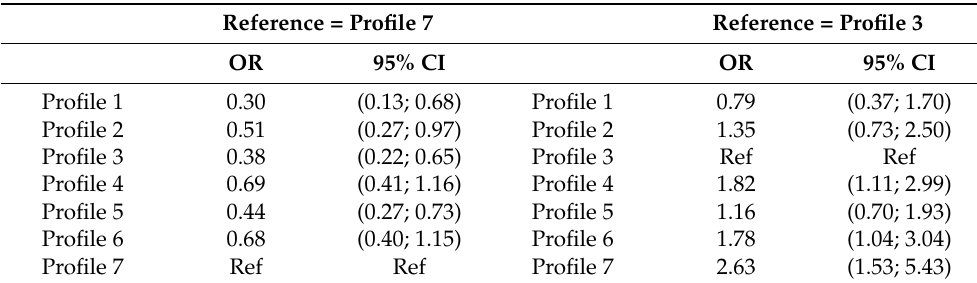
Table 4. Associations with relapse for each profile compared to two reference groups: the largest overall profile (Profile 7) and the profile with approximately equal numbers in remission and not in remission at 3 to 4 months (Profile 3).